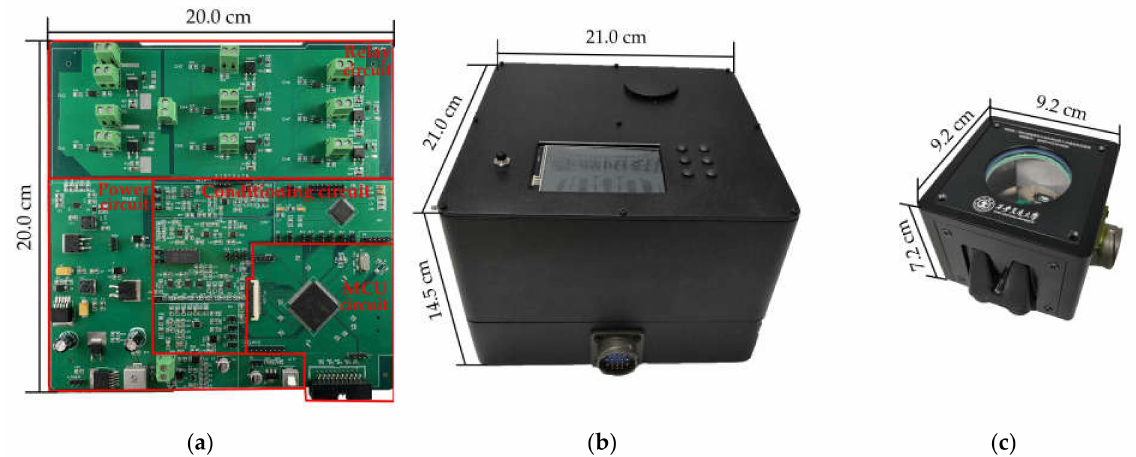
Figure 6. Photos of ( a ) the circuit board, ( b ) the control chamber, ( c ) the test